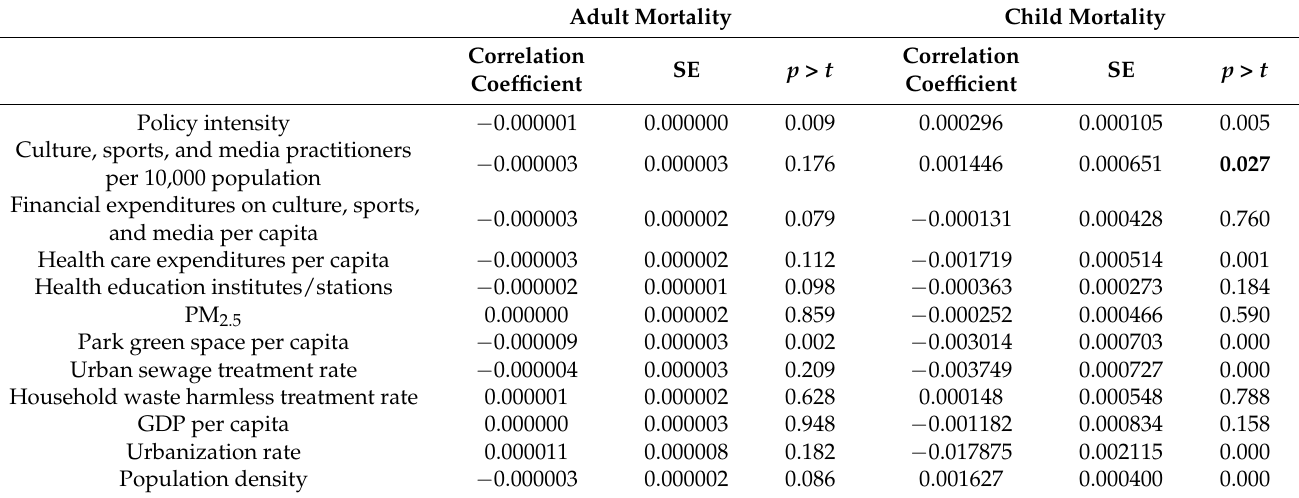
Table 2. Regression results of